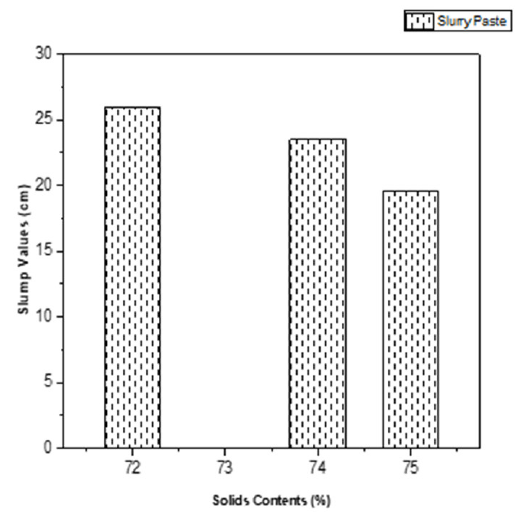
Figure 5. Slump values for different CTB at Cw 72 wt. %, 74 wt. % and 75 wt. % and binder of 1 wt. %.